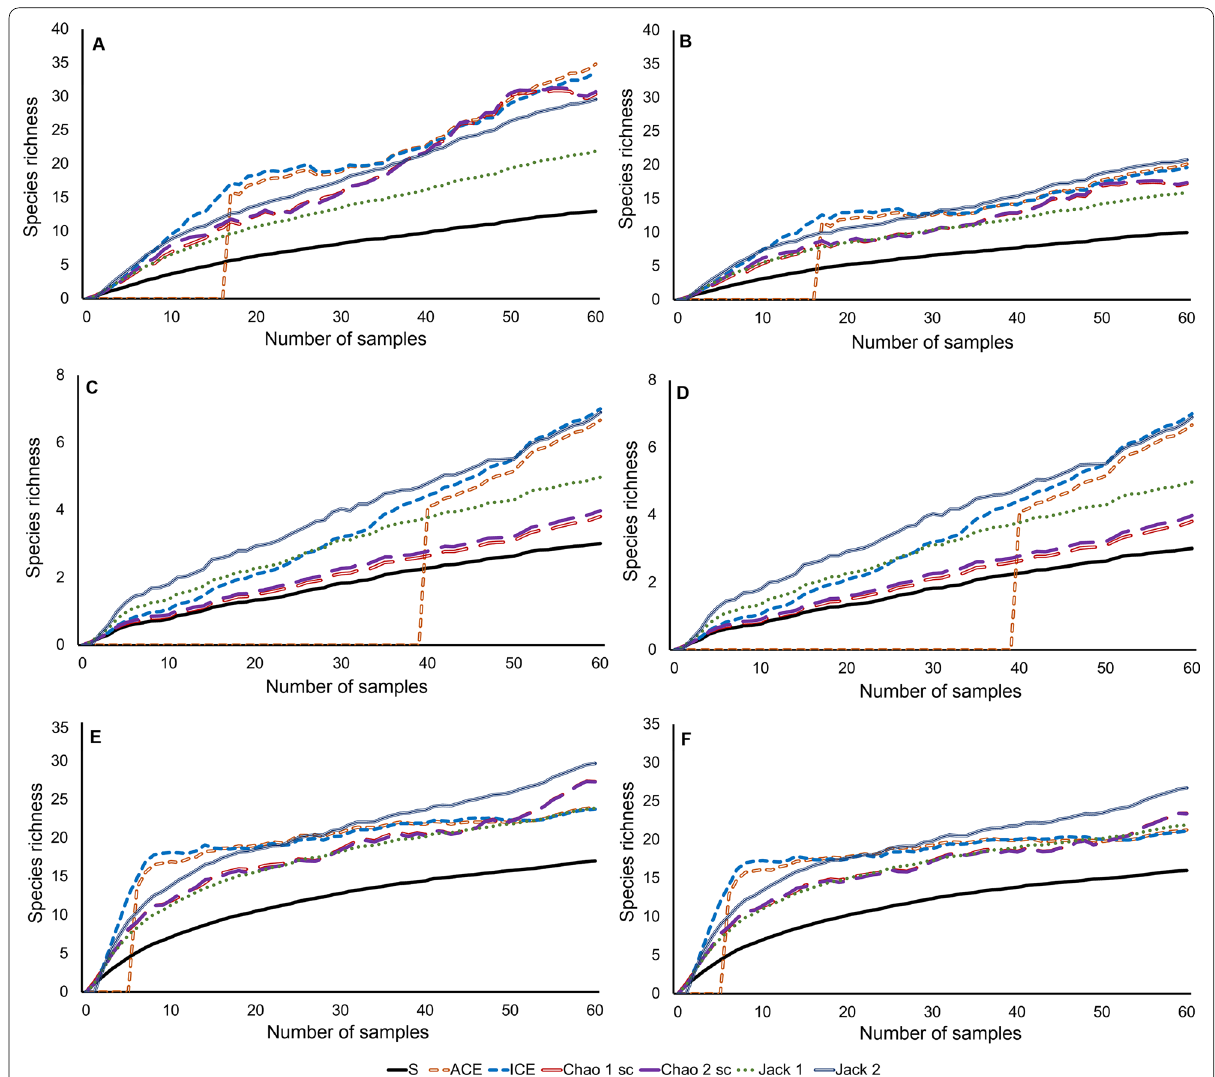
Fig. 9 Species richness estimation curves for Pampa del Indio Provincial Park, Chaco, Argentina, with adult data. A , B : foliage, C , D : leaf litter, E , F : grassland; A – C – E : analyses with HTS; B – D – F : analyses without